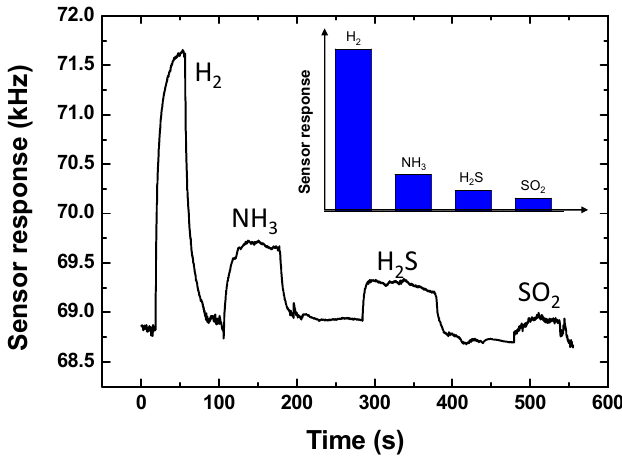
( b ) Figure 9. The measurement of the long-term stability of the 40 nm Pd-Ni alloy thin-film coated device ( a ), and the 40 nm Pd thin-film coated device ( b ). 4.5. Selectivity Testing An experiment was performed to describe the selectivity of the proposed 40 nm Pd-Ni alloy